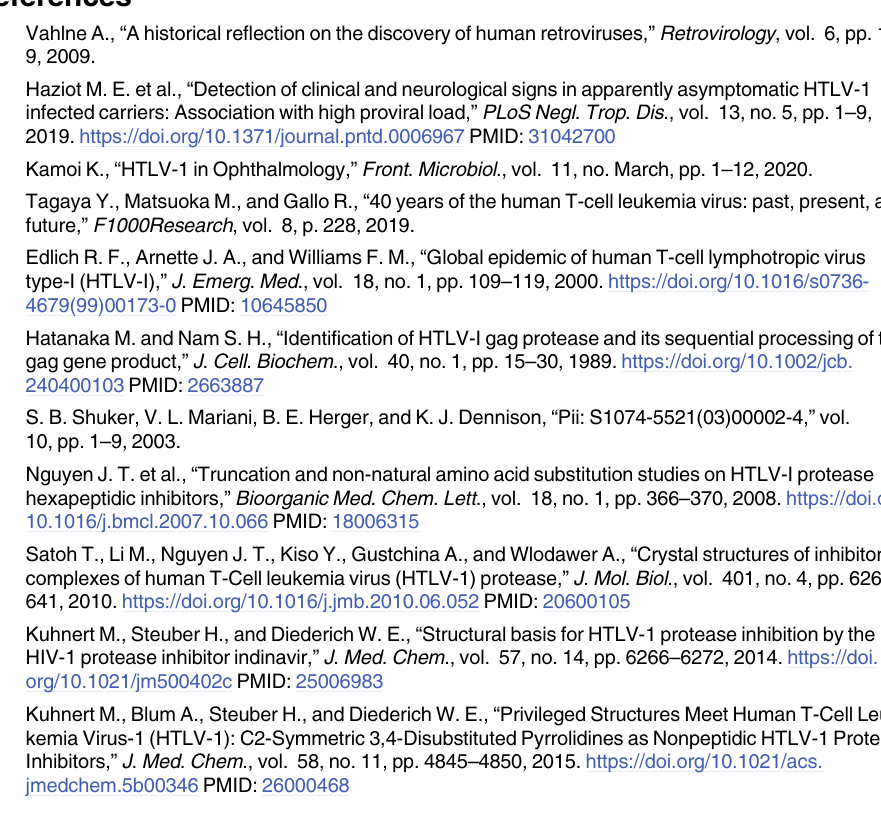
S1 Fig. The free energy landscape plots of all